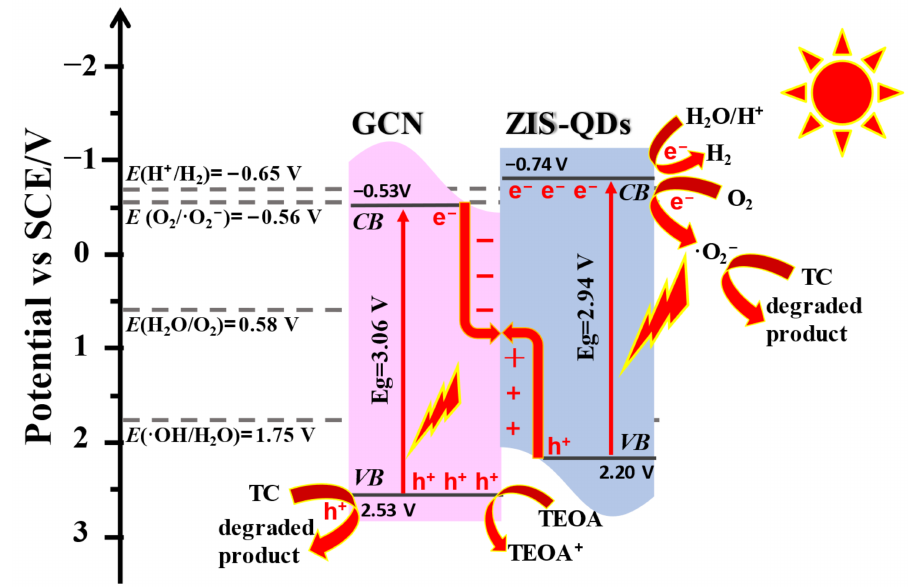
Figure 10. Photocatalytic mechanism of the ZIS/CN